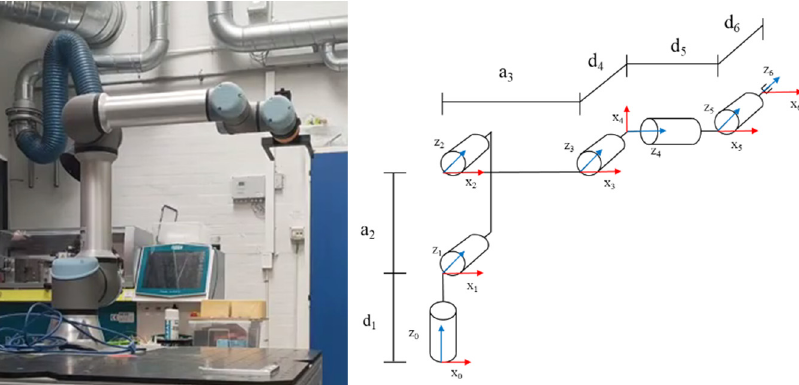
Figure 7. UR5E robot and its linkage coordinate system. Table 4. Robotic arm D-H parameters.